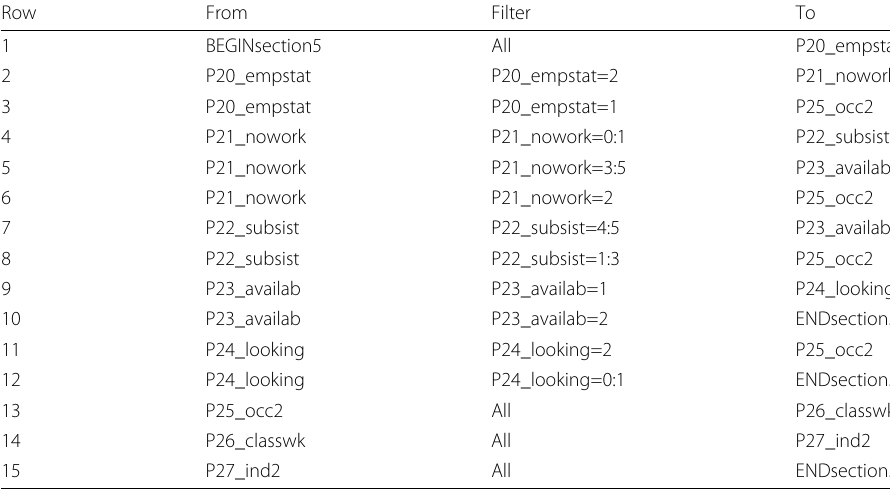
Table 2 Questionnaire progression table: Malawi 2008 Census economic activity questions